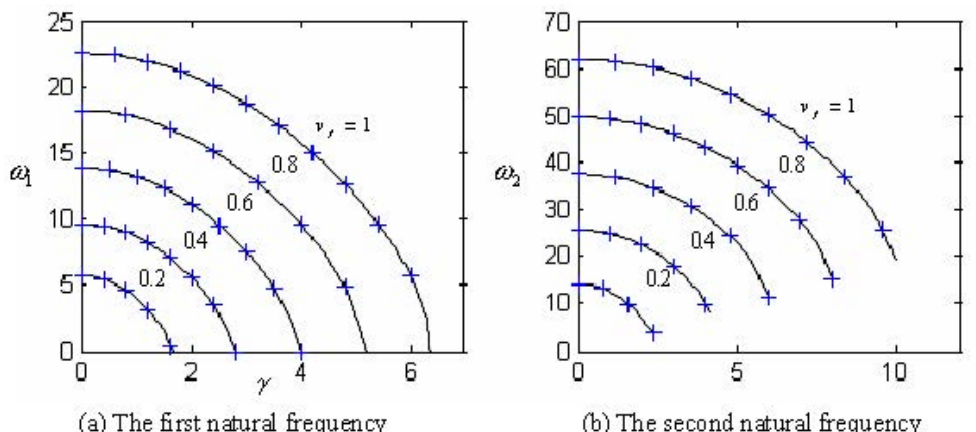
Figure 3. The subcritical natural frequencies for fixed supports.